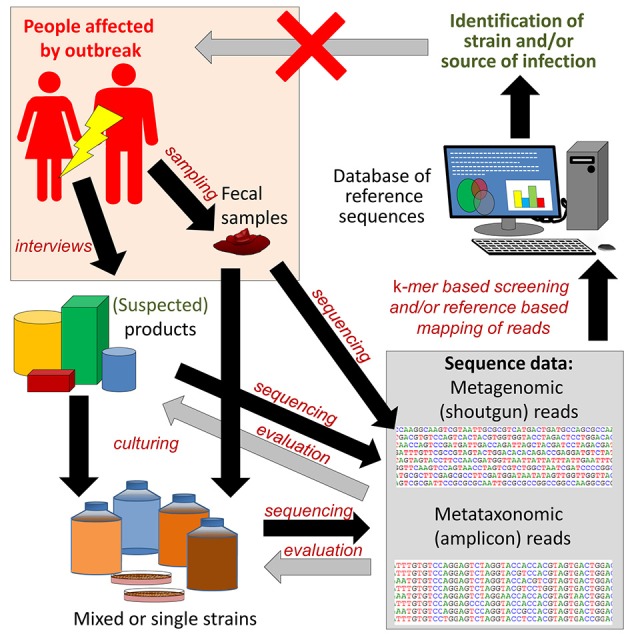
Reference guided metagenome sequencing based approach for identification and characterization of pathogenic and outbreak associated strain(s). In case of an outbreak, fecal samples from patients are subjected to culturing, in order to isolate the outbreak strain. Patients are also interviewed in order to try to identify food products that may be the source(s) of infection. The metagenomes of stool samples, food products and cultured strains can then be amplicon sequenced (metataxonomics) or shotgun sequenced (metagenomics) and the data mapped to reference databases for identification of virulence markers. Shotgun reads can also be assembled into larger contigs or genomes for identification of pathogenic strains. The latter is facilitated if the sequence data are derived from single isolates. Black arrows indicate forward flow direction of the analysis, while gray arrows indicate feedback changing the premises for earlier steps. Feedback from the sequencing analysis can be used to refine and narrow the search for a specific FBP. If successful, the outbreak will be terminated. This review includes multiple examples of the application of the described approach to outbreak investigations.